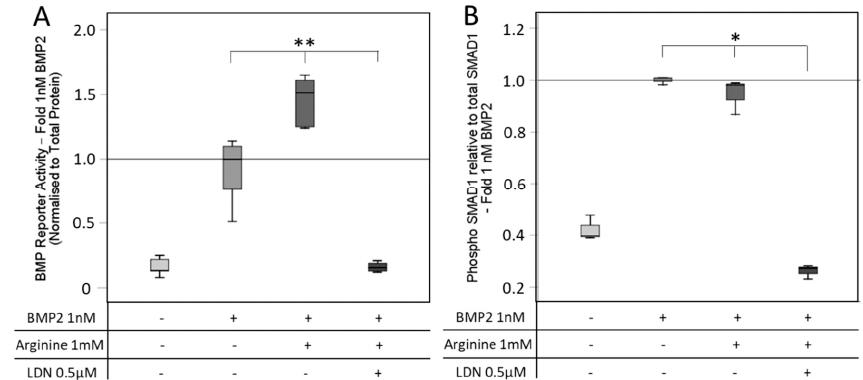
Figure 9. BMP reporter activity and SMAD1 phosphorylation after inhibition of the SMAD pathway.